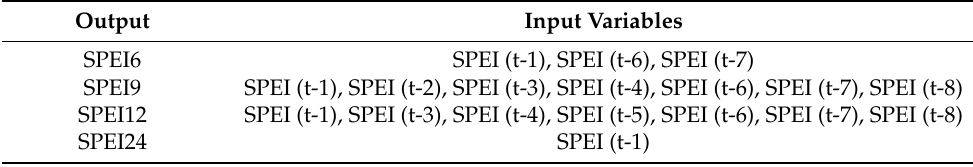
Table 4. Input variables selected for multiscale SPEI prediction.